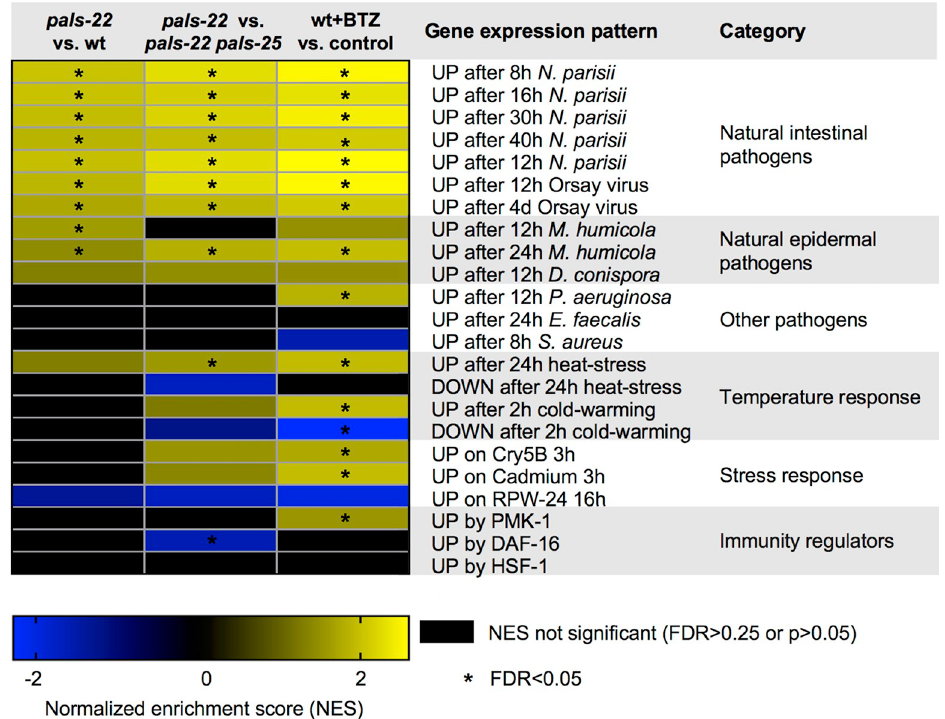
Fig 7. Functional enrichment analysis of genes transcriptionally regulated by the pals-22/25 gene pair. Correlation of genes transcriptionally regulated by the pals-22/25 gene pair and genes differentially expressed due to bortezomib treatment with genes that are up- or downregulated in response to infection by pathogens or other environmental stresses. Analysis was performed using the GSEA 3.0 software package (see Materials and Methods) and correlation is quantified as a Normalized Enrichment Score (NES). A positive NES (yellow) indicates correlation with upregulated genes in the denoted comparison while a negative NES (blue) indicates correlation with downregulated genes. Black cells indicate no significant correlation was detected, a FDR > 0.25, or p > 0.05). � FDR < 0.05. For more detailed results, see S7 Table. For details on the gene sets used see S6